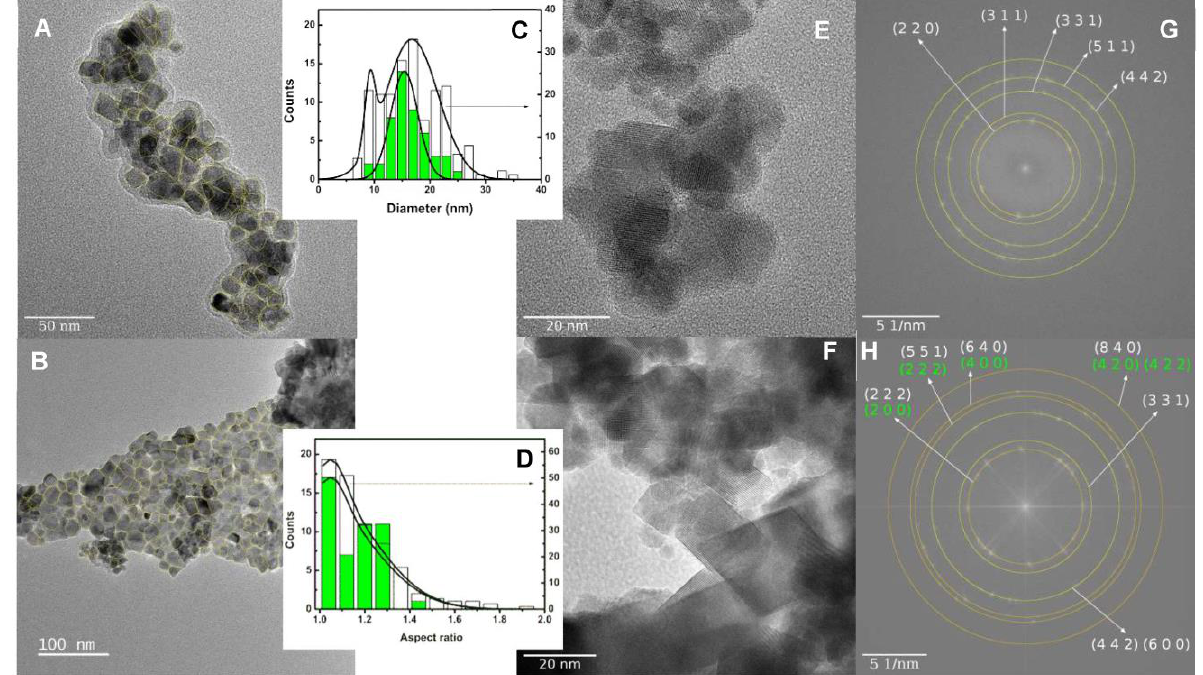
Figure 5. TEM images of a plain Zn/Ca mixed ferrite ( A,E ) and coupled with silver ( B,F ). Size ( C ) and aspect ratio ( D ) histograms resulting from outlined particles where filled bars are for plain mixed ferrite. Panels ( G ) and ( H ) show the fast Fourier transform (FFT) of, respectively, images E and F, and include the identified electron diffraction rings from their Miller indices for Zn/Ca ferrite spinel (white) and silver fcc (yellow) crystal structures.